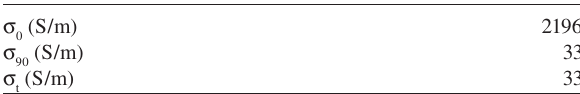
Figure 4 Analysis model and delamination crack confi guration.